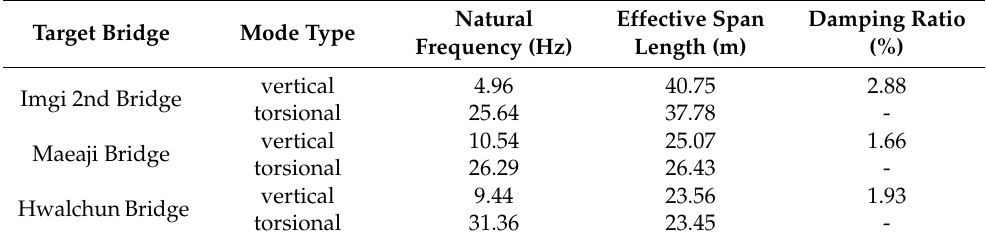
Table 3. Dynamic properties estimated from the target